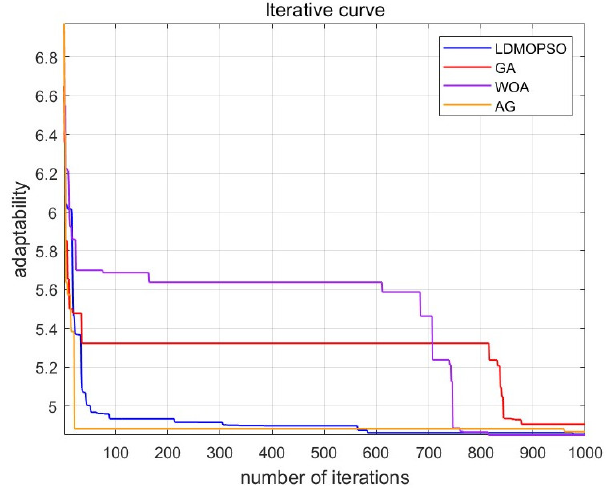
Figure 2. The average objective function convergence curves of each of the 4 algorithms over 50 runs.